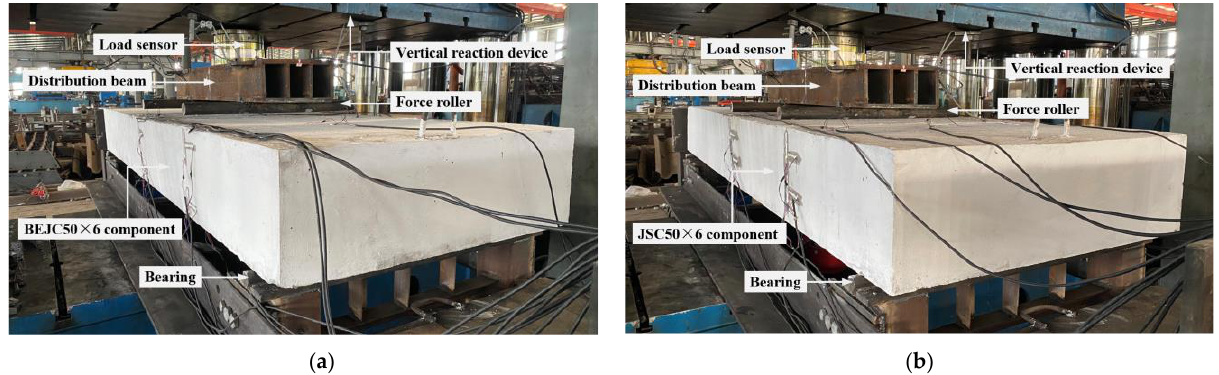
Figure 5. Indoor loading tests. ( a ) The BEJC50 × 6 component and ( b ) the JSC50 × 6 component.